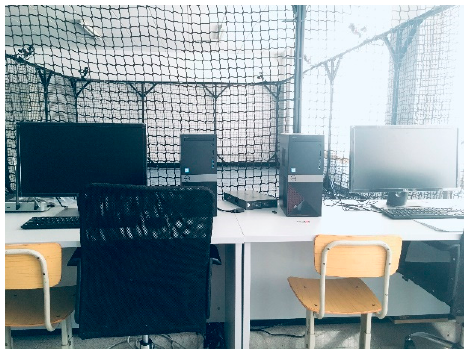
Figure 6. The indoor optical positioning system platform.